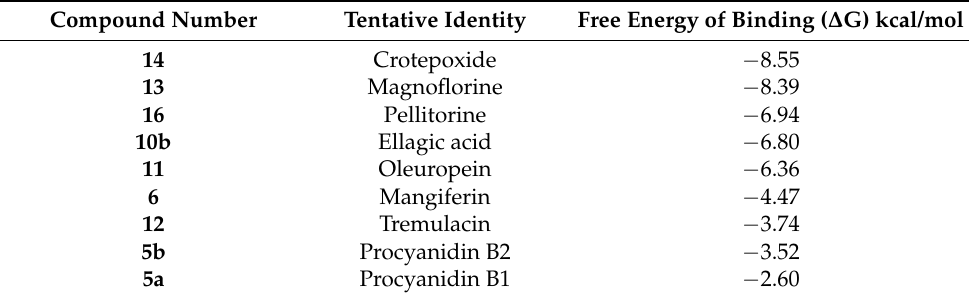
Table 1. Calculated free energy of binding of ligands docked with